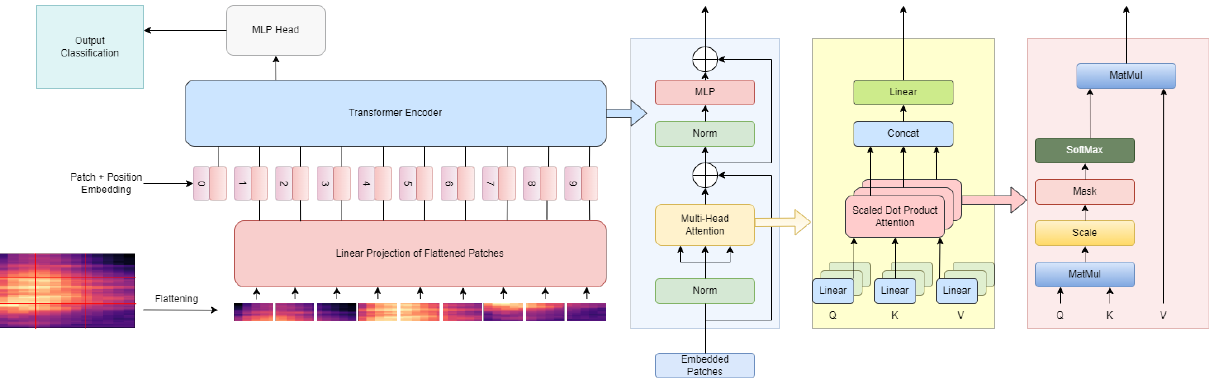
Figure 4. Architecture of Vision Transformer (MLP—Multilayer